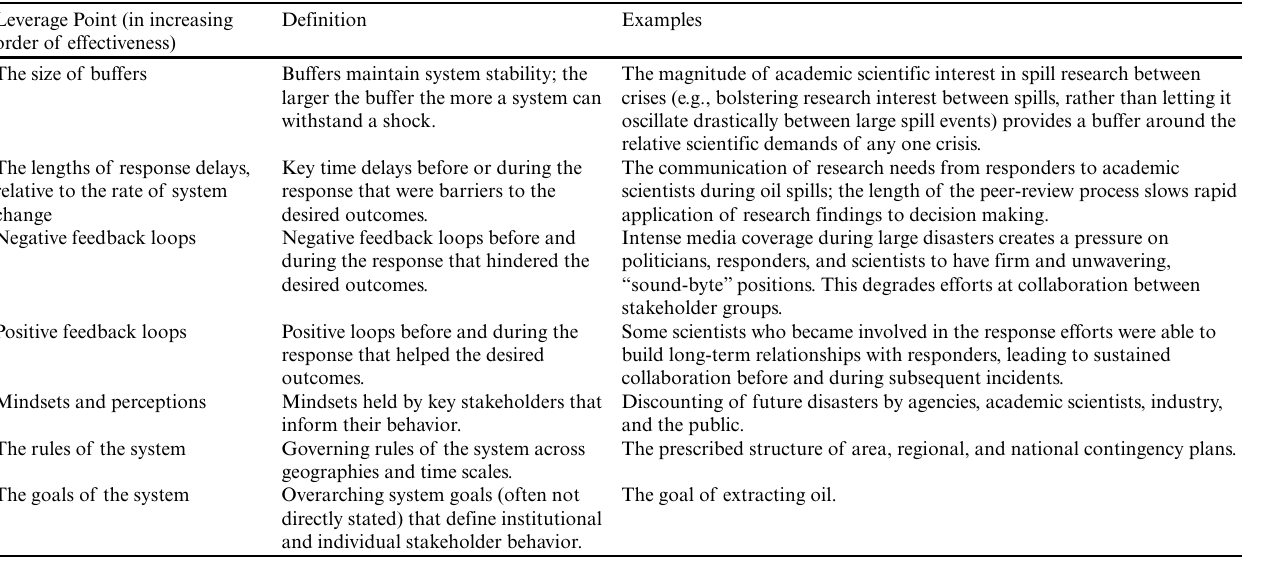
Table 1 . System leverage points used to identify priority root causes for